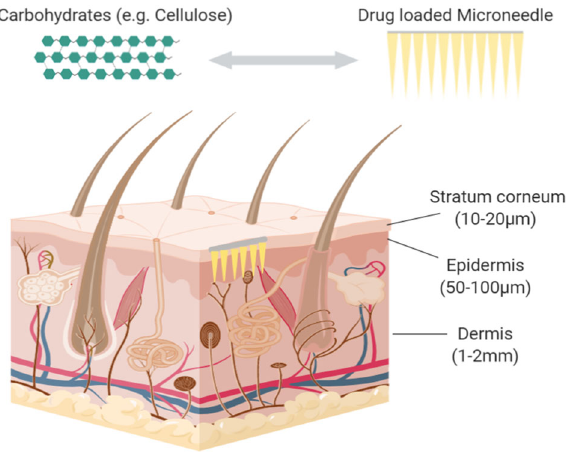
Fig. 3 Schematic representation of a microneedle inserted into the